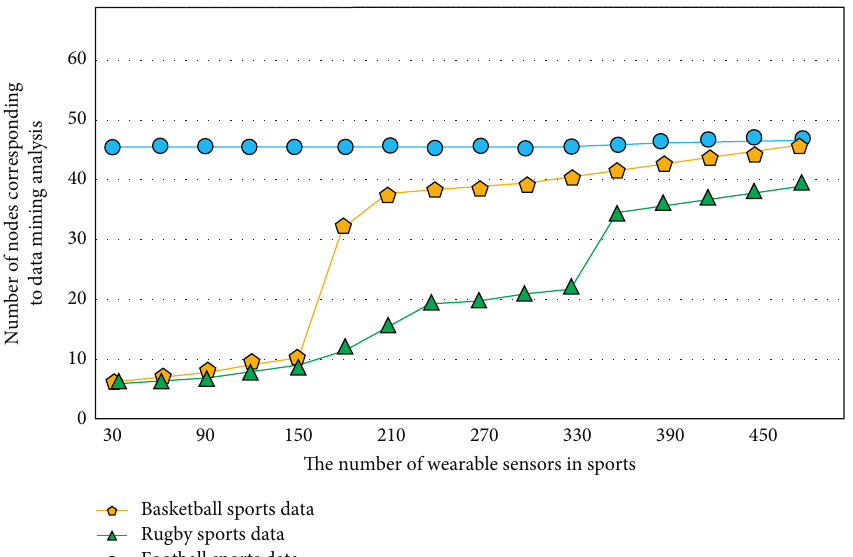
Figure 3: Simulation analysis of the relationship between different numbers of sensors and the number of data mining nodes under big data analysis